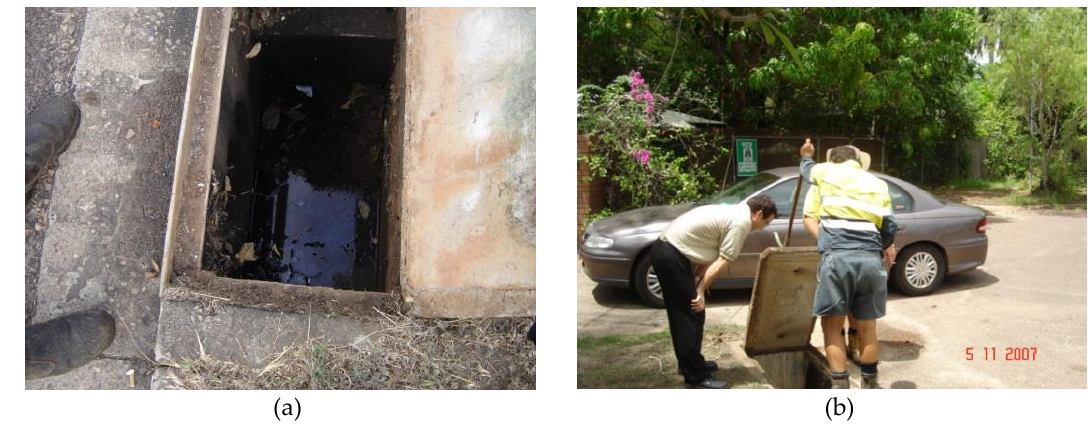
Figure 1. ( a ) Drain sump with dry season stagnant water in Rapid Creek; ( b ) inspecting drain pits.